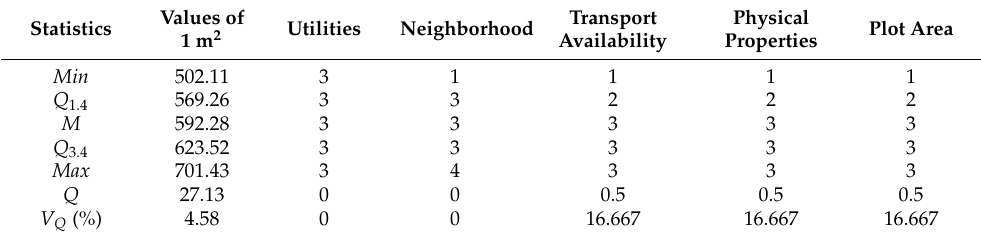
Figure 3. Location of the valued properties. Table 1. Real estate attributes and their states. Table 2. Descriptive statistics in unitary values (in PLN—Polish zlotys) of real properties and their attributes defined for a set of 318 real